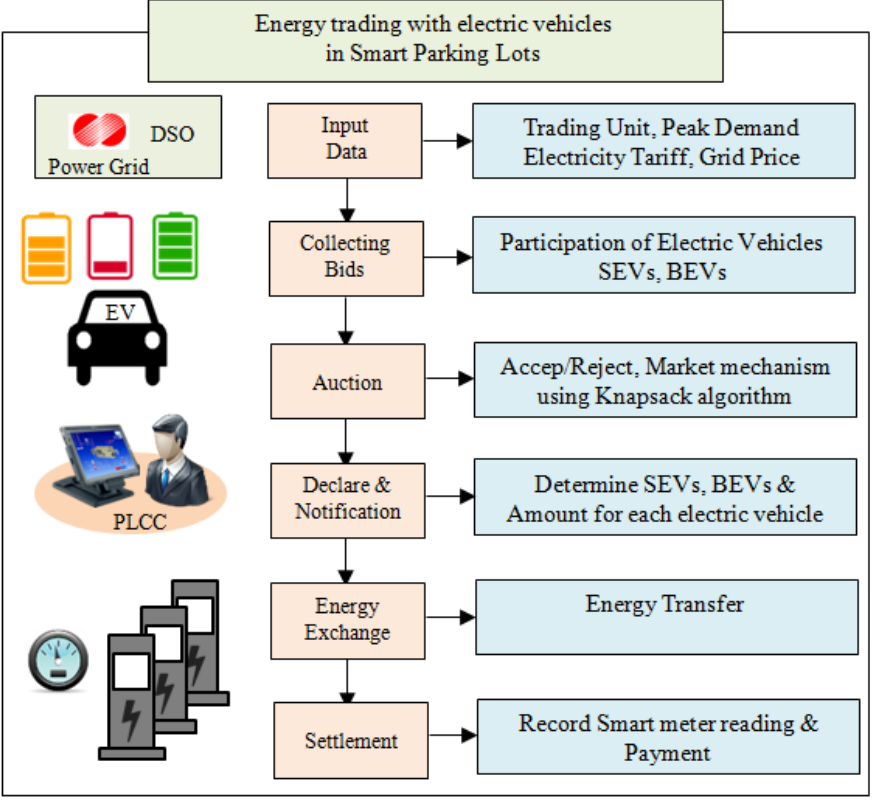
Figure 2. Overview of the proposed energy trading system in a smart parking lot. SEV: seller electric vehicle; BEV: buyer electric vehicle; DSO: distribution system operator; PLCC: parking lot control center.